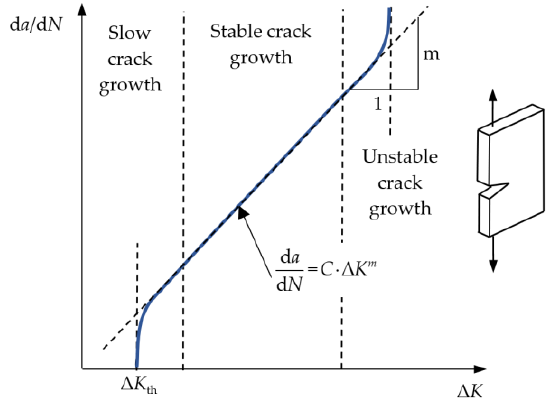
Figure 7. Typical crack propagation curve.